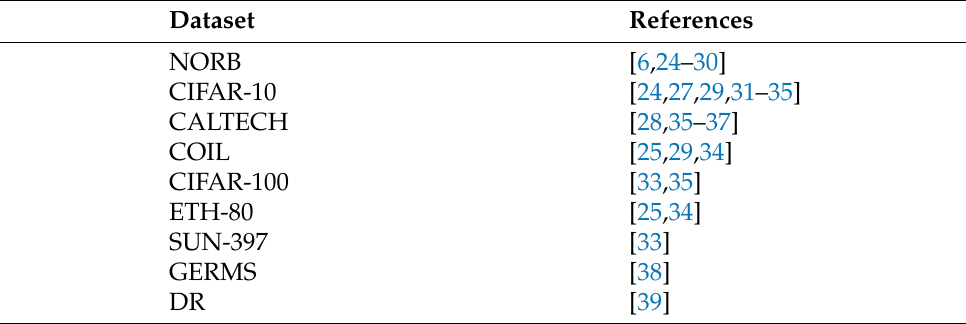
Table 2. Datasets for object recognition reported in the primary